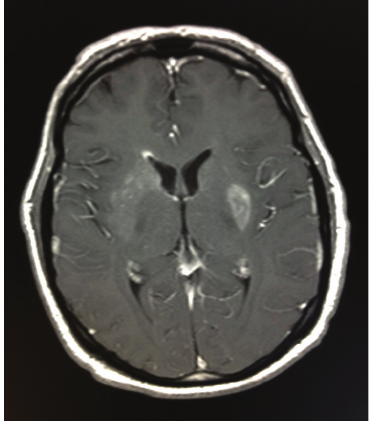
Figure 3: Axial T1 postgadolinium demonstrates enhancement along the periventricular white matter of the right frontal horn and in the left putamen.